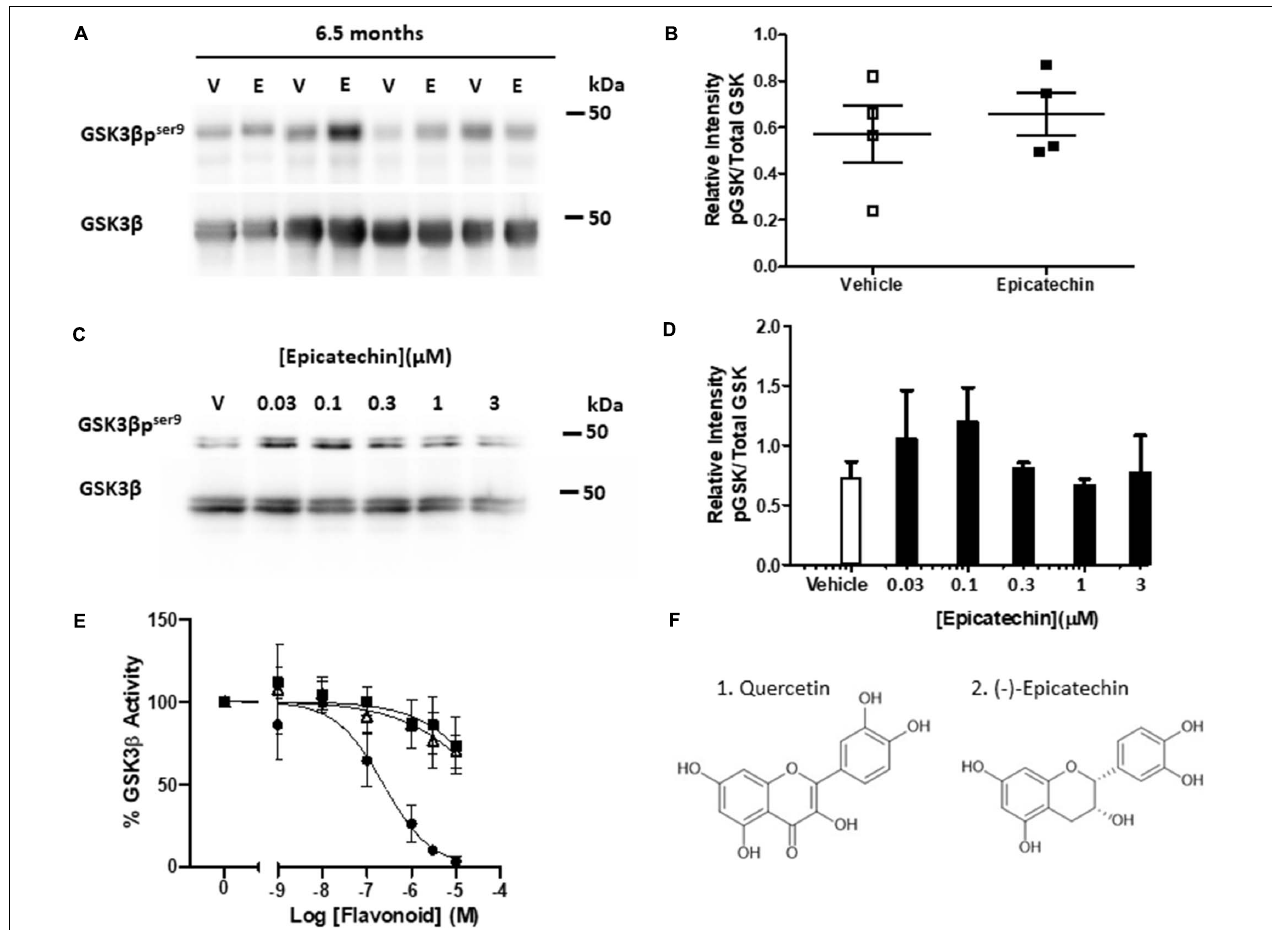
FIGURE 2 | ( − )-Epicatechin does not inhibit GSK3 β activity either in vivo or in vitro . (A) Immunoblots of whole brain homogenates (20 µ g) from 6.5 month-old rTg4510 male mice exposed to either vehicle (V) or EC (E) probed with antibodies against GSK3 β and GSK3 β phosphorylated at Ser9 (GSK3 β p ser 9 ). (B) Scatter plot showing quantification of changes in phosphorylation status of GSK3 β as a ratio of total GSK3 β for vehicle (open squares) and EC (black squares) treatments, no significant differences ( n = 4). (C) Immunoblots of primary cortical neurons treated for 15 min with vehicle (V) or increasing concentrations of EC (0.03–3 µ M) and probed with antibodies against GSK3 β and GSK3 β phosphorylated at Ser9 (GSK3 β p ser 9 ). (D) Quantification of changes in the phosphorylation status of GSK3 β as a ratio of total GSK3 β . Data is mean ± SEM ( n = 3). (E) Sensitivity of GSK3 β catalytic activity to increasing concentrations of flavonoids (1 nM–10 µ M). Data presented as% activity related to vehicle control (100%). Quercetin (black circles), EC (black squares), EGCG (open triangles), mean ± SEM ( n = 4). (F) Structures of Quercetin (1) and EC